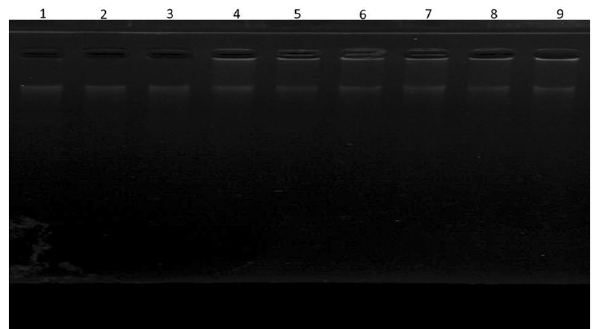
Figure 2. Agarose gel electrophoresis of the glycated DNA incubated with fructose for 5, 10, and 15 days (lane 1–3), the native DNA (lane 4–6), and DNA + Fructose after treating with RA for 5, 10, and 15 days (lane 7–9). Electrophoresis was carried out on the 1.5% agarose gel for 1.5 h at 100 v.